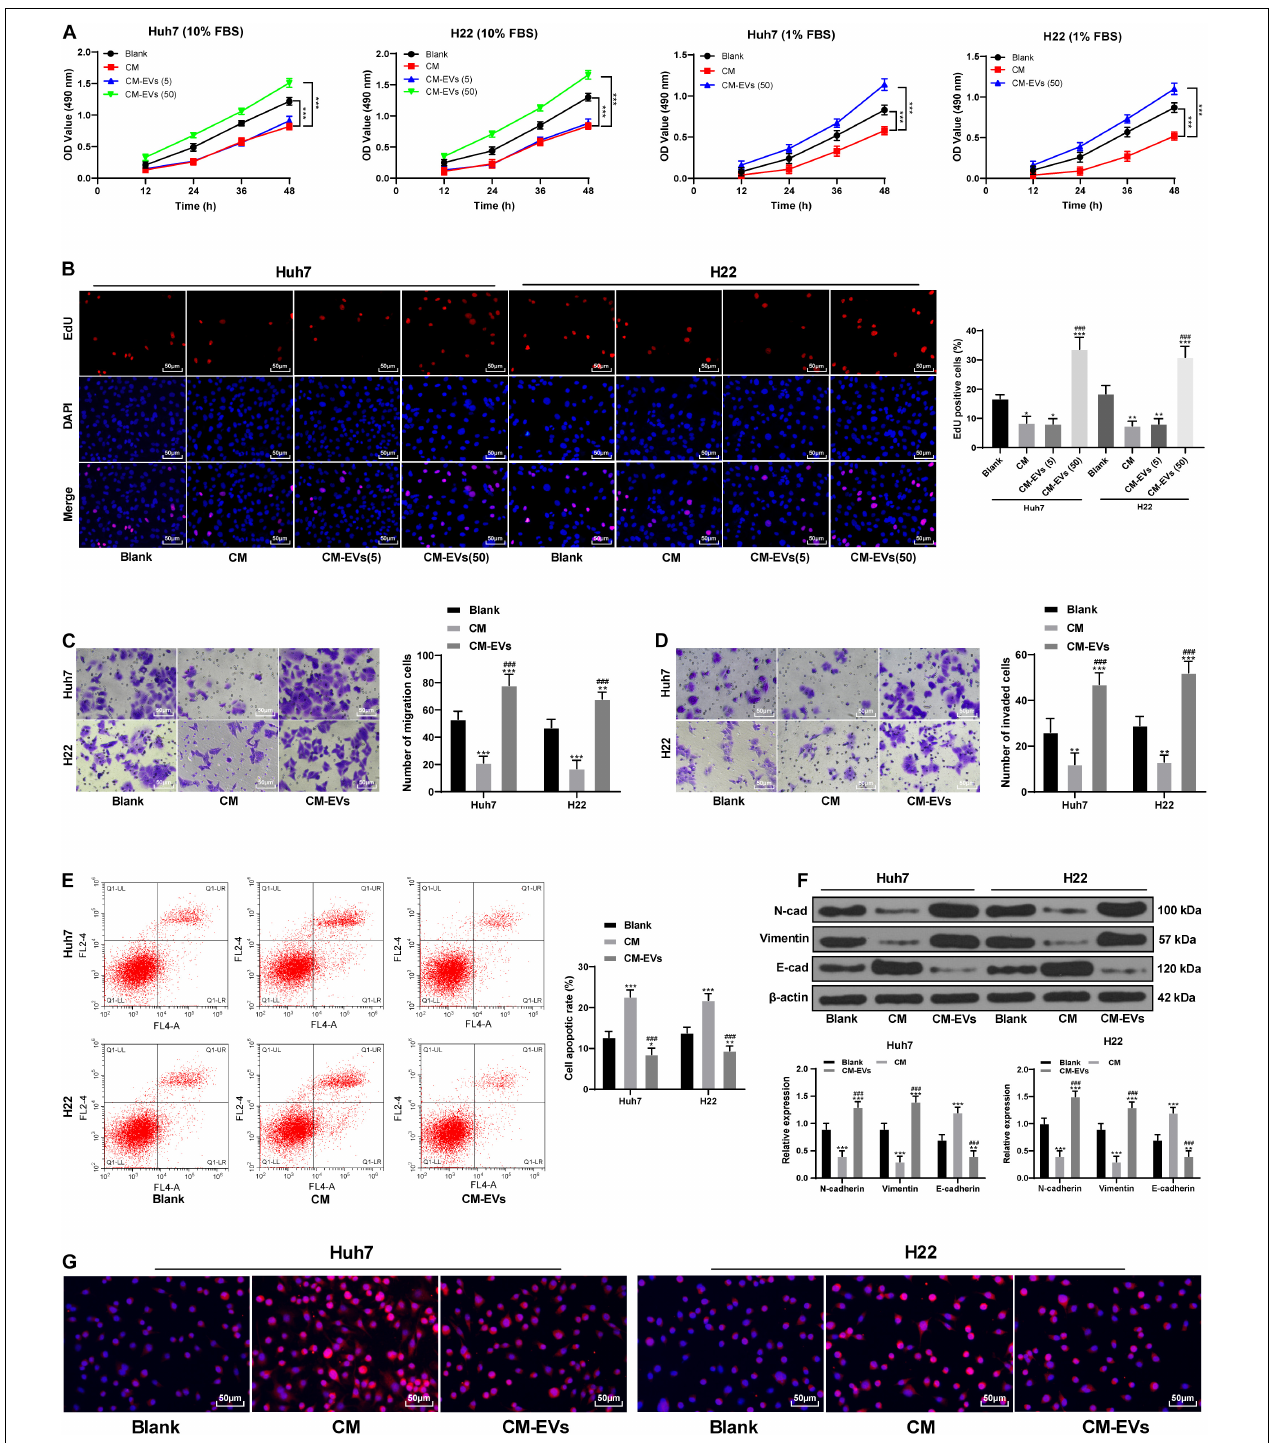
FIGURE 3 | BMSCs that differentiated into fibroblasts after the action of EVs promoted EMT and invasion and migration of Huh7 and H22 cells. MTT assay (A) and EdU assay (B) were used to detect the proliferation ability of Huh7 and H22 cells incubated with BMSCs-CM treated with different concentrations of EVs. (C,D) Transwell assays were used to detect the invasion and migration abilities of Huh7 and H22 cells incubated with CM-EVs. (E) Flow cytometry was used to detect the apoptosis rate of Huh7 and H22 cells incubated with CM-EVs. (F) Western blot analysis was used to detect the expression of EMT-related proteins in Huh7 and H22 cells incubated with CM-EVs. (G) immunofluorescence was used to verify the positive expression of E-cadherin in Huh7 and H22 cells; compared with the blank group, * p < 0.05 ** p < 0.01, *** p < 0.001; compared with the CM group, ### p < 0.001. Data were analyzed by one-way ANOVA, followed by Tukey’s multiple comparison test. Replicates =